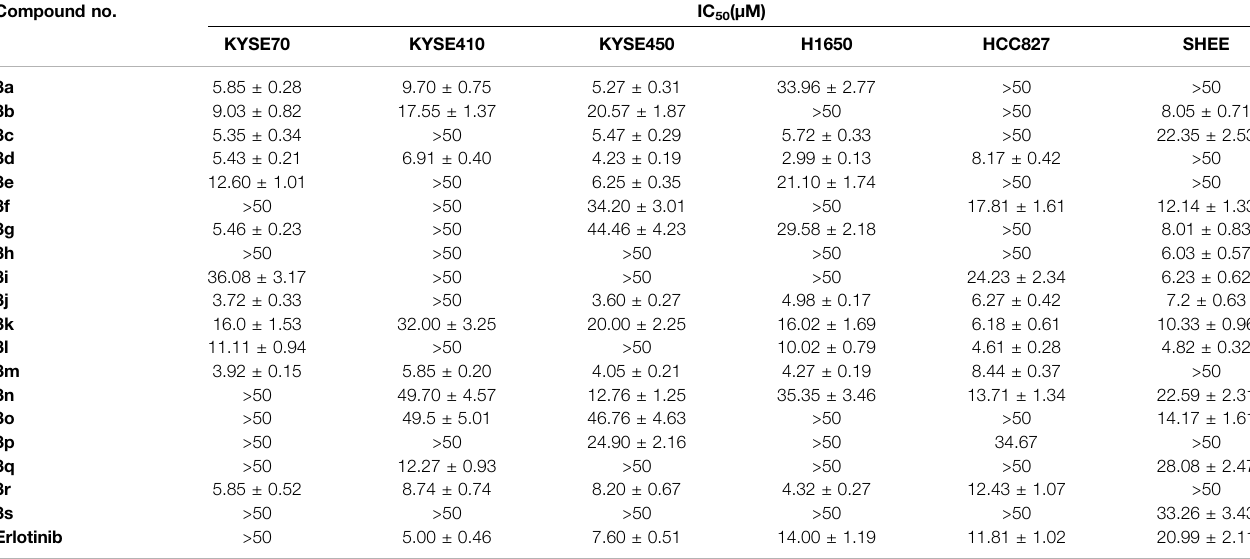
TABLE 3 | Anti-proliferative activities of compounds 3a-3s against different cell lines. Compound